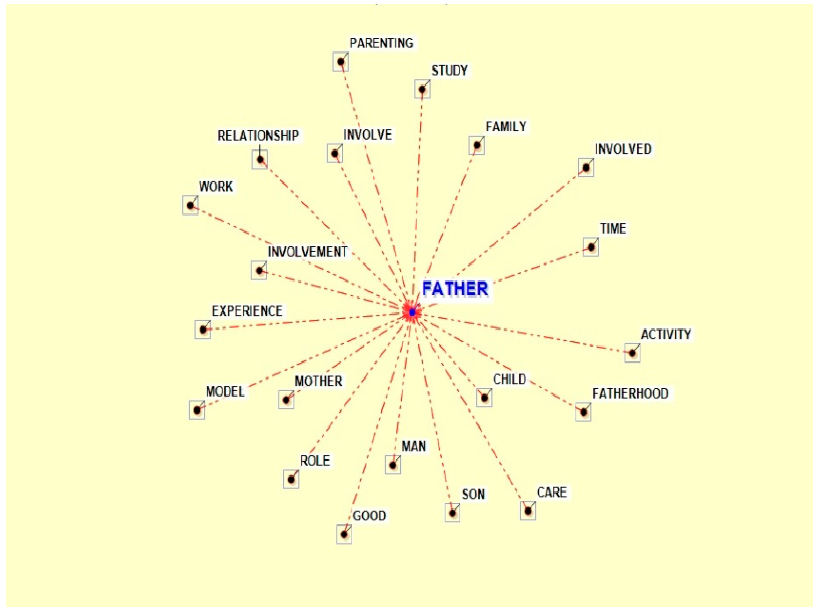
Figure 9. Radial diagram with “father”.